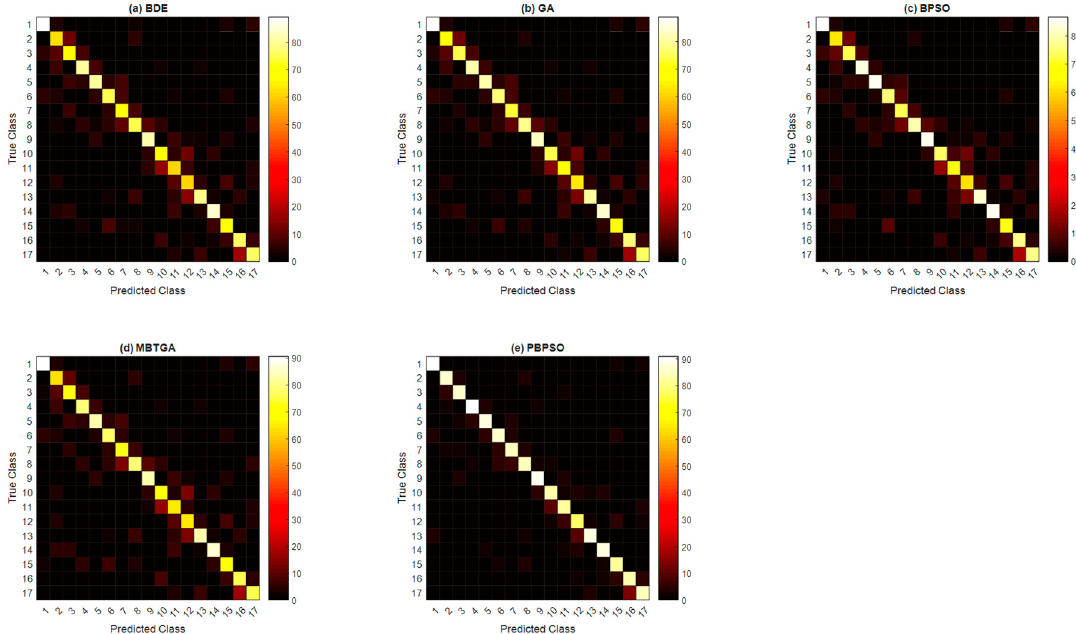
Figure 7. The overall confusion matrix of five different feature selection methods across 11 amputee subjects.